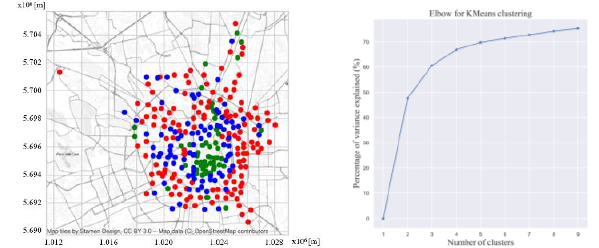
Figure 17. K-Means clustering on the normalized departures. (Left side) Stations clusters spatial distribution (k=3). (Right side) Explanatory capacity for adding a cluster.